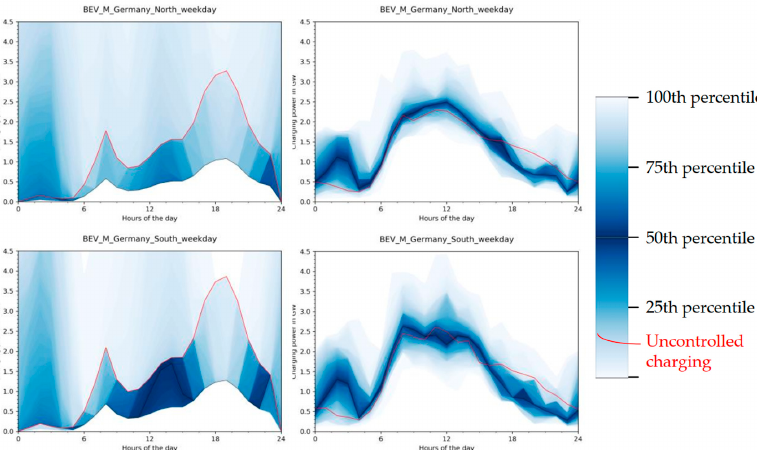
Figure 5. Annual distribution of total charging on weekdays in cost-minimal power system operation. The red line indicates how charging would take place in case of uncontrolled charging. The black line indicates the median value for charging in each hour (not the median profile). Figures on the left are the distributions for Northern Germany and Southern Germany for the medium sized BEV fleets for scenario S1 (VencoPy profiles). Figures on the right side depict charging distributions in scenario S2.